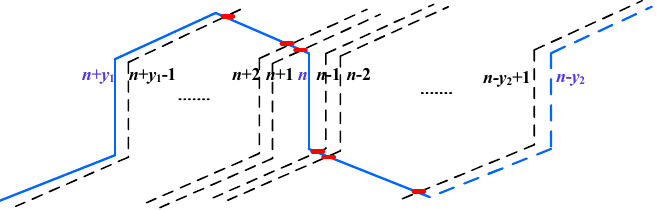
Figure 9. Position of the possible end short-circuit faults.